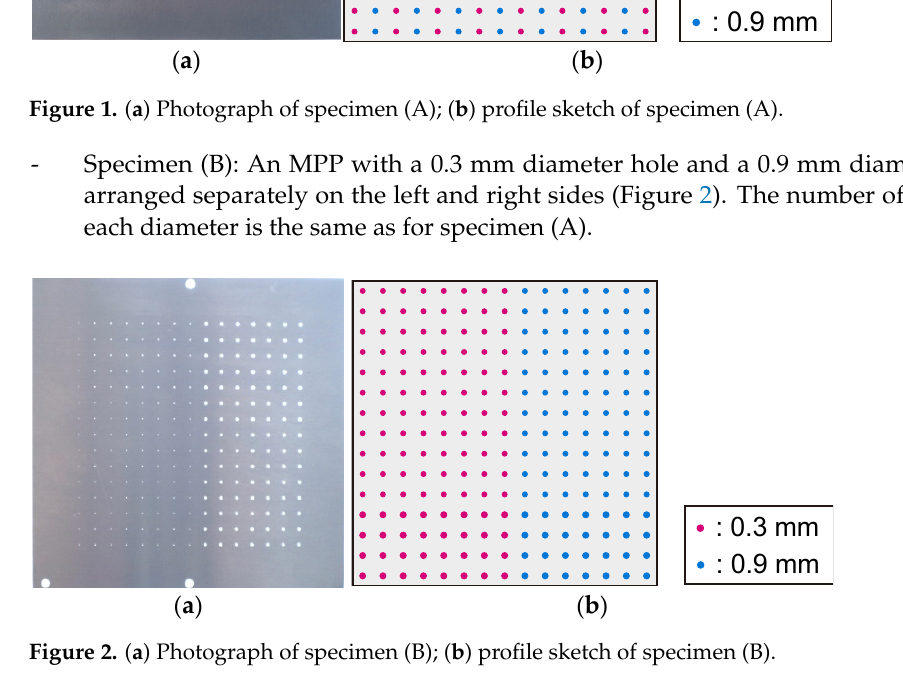
Figure 2. ( a ) Photograph of specimen (B); ( b ) profile sketch of specimen (B).